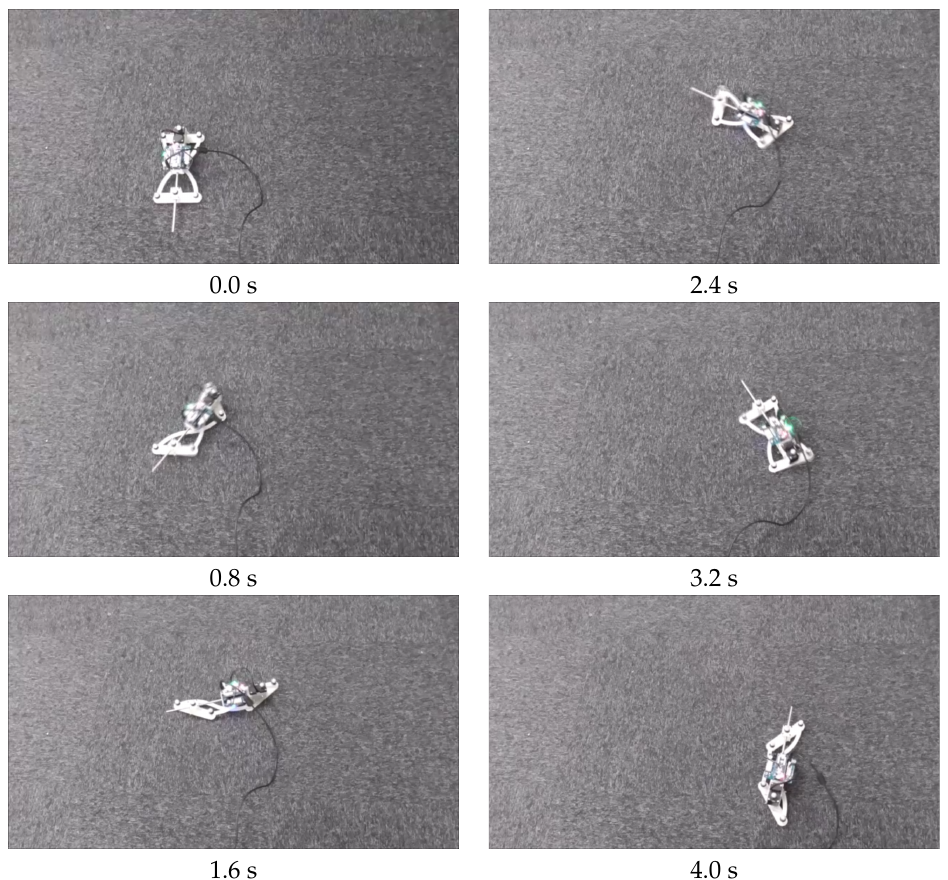
Figure 25. Snapshots of the clockwise turning locomotion